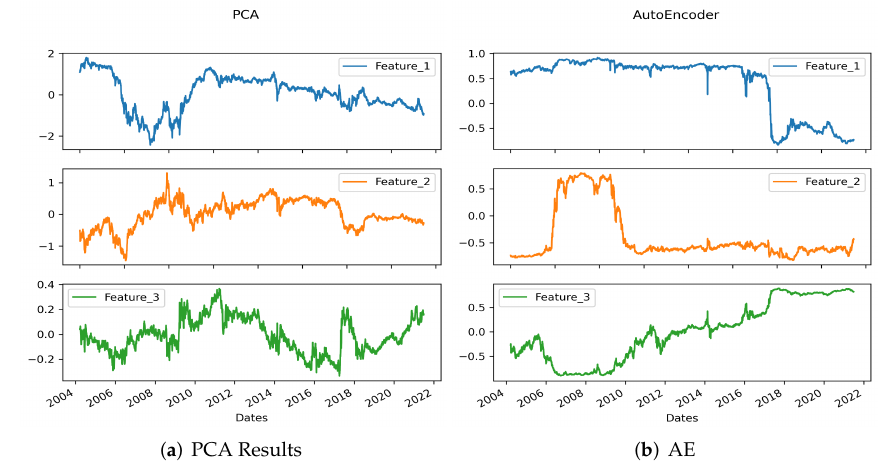
Figure 17. Comparison of the results of PCA and AE for the Japan